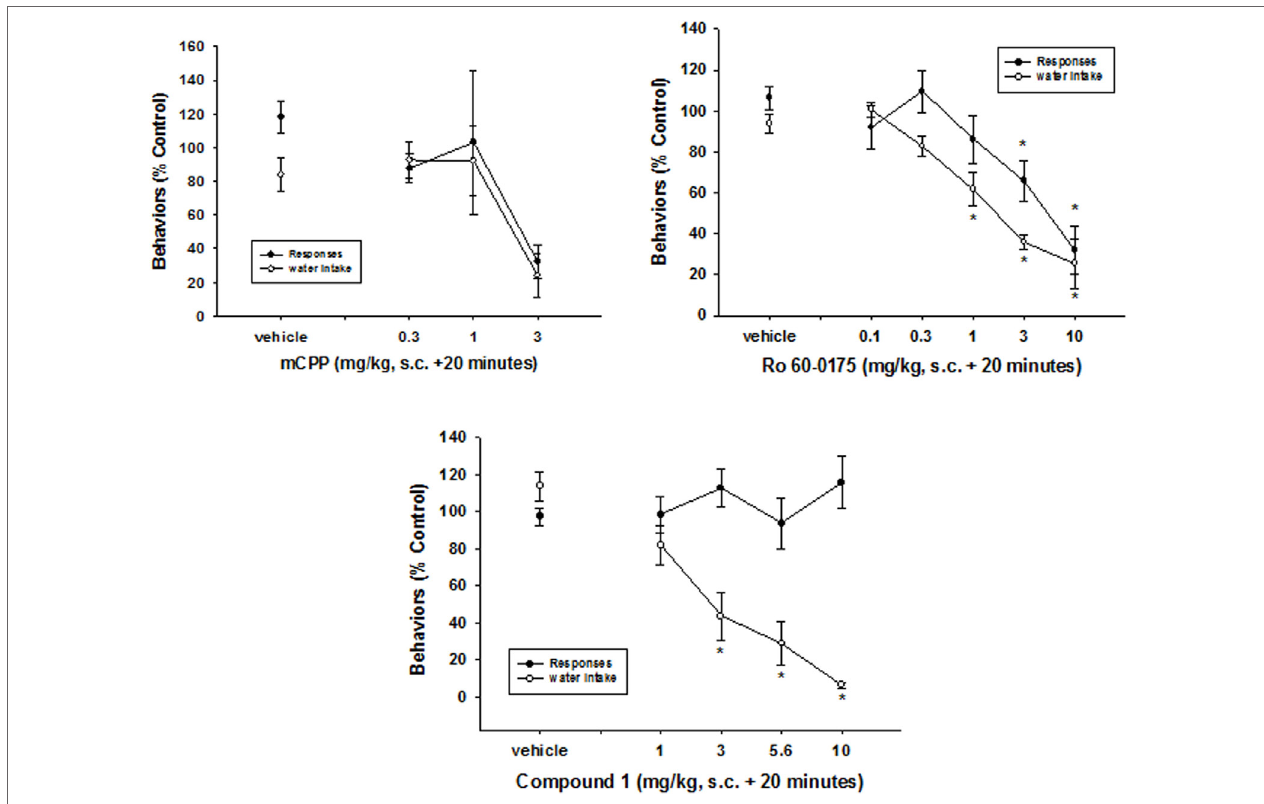
FigUre 5 | effects of 5hT 2c receptor agonists on schedule-induced polydipsia . mCPP and Ro 60-0175 significantly decreased both the number of responses emitted and the amount of water consumed (mCPP: reponses— F 2,23 = 17.1, p < 0.0001; water— F 2,23 = 13.5, p < 0.001) (Ro-60-0175: responses— F 4,39 = 8.6, p < 0.0001; water— F 2,23 = 13.5, p < 0.001). In contrast, CPD1 dose-dependently suppressed excessive water drinking ( F 3,31 = 9.5, p < 0.001) without affecting response output ( F 3,31 = 0.37, p = 0.78). Each point represents the mean ± SEM of five to eight rats. * p < 0.05 compared to vehicle (Dunnett’s